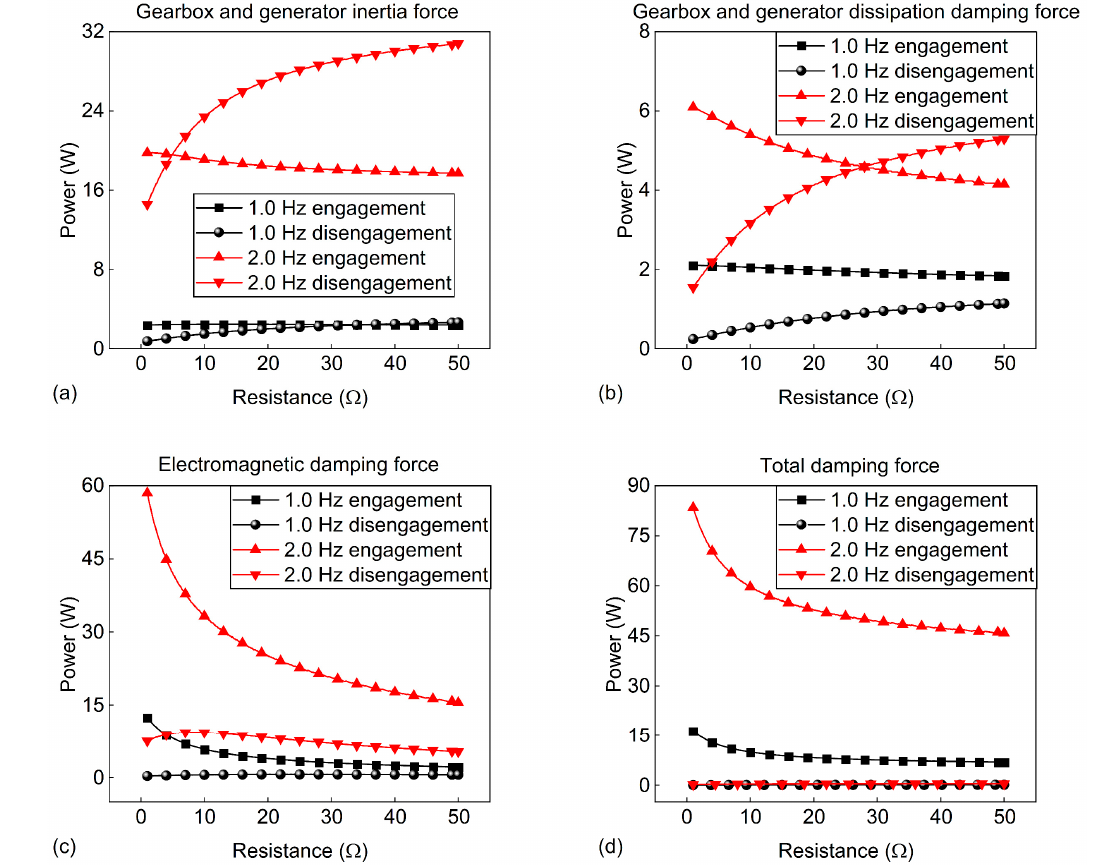
Figure 12. Different force powers with different resistances (parameters of input: A = 20 mm). ( a ) Power of the inertial force of the gearbox and the generator. ( b ) Gearbox and generator dissipation damping force. ( c ) Electromagnetic damping force. ( d ) Total damping force.